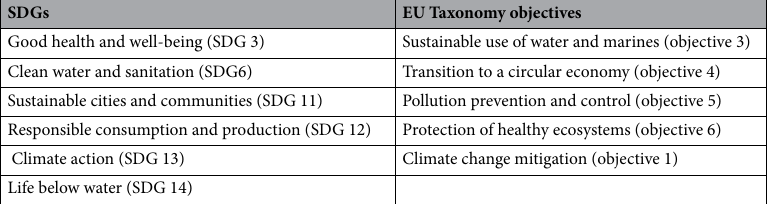
Table 1. SDGs and environmental objectives in the EU Taxonomy related to our